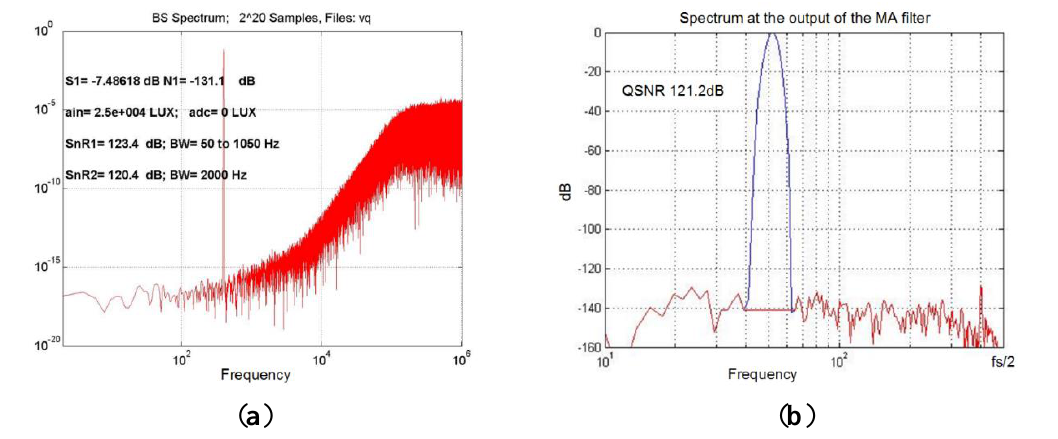
Figure 10. Spectra of the bit-stream for a sine-wave input light with an amplitude of 24 k Lux. The frequency is 1kHz and produces a 300 nA amplitude: ( a ) the spectrum of the bit-stream with chopping off; the most important non-ideal effects are included;